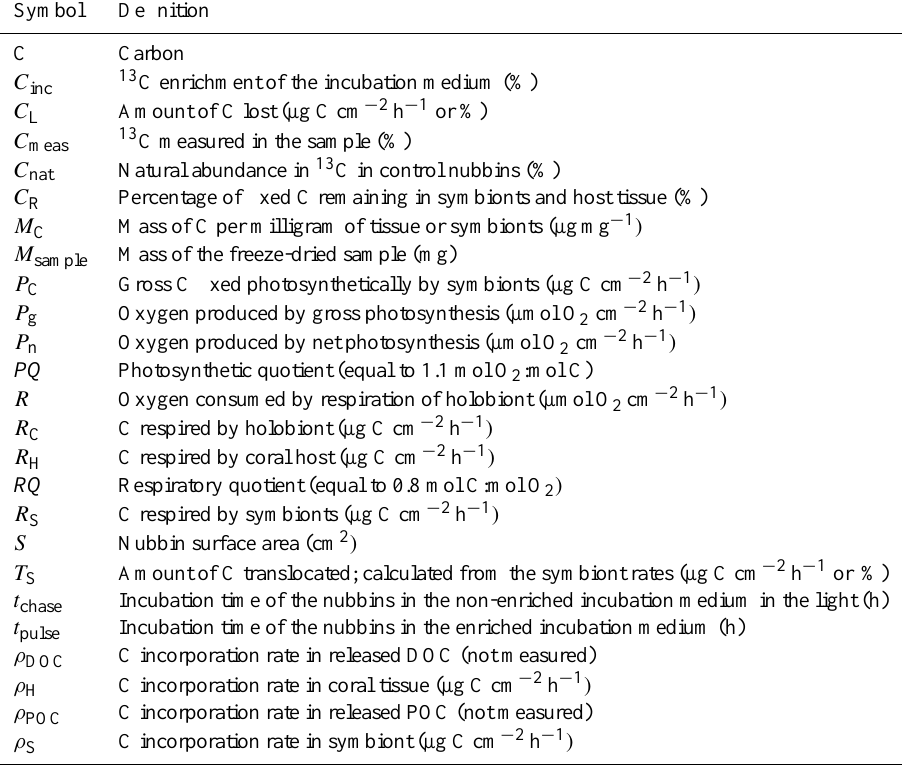
Table 2. List of symbols, definition and units.